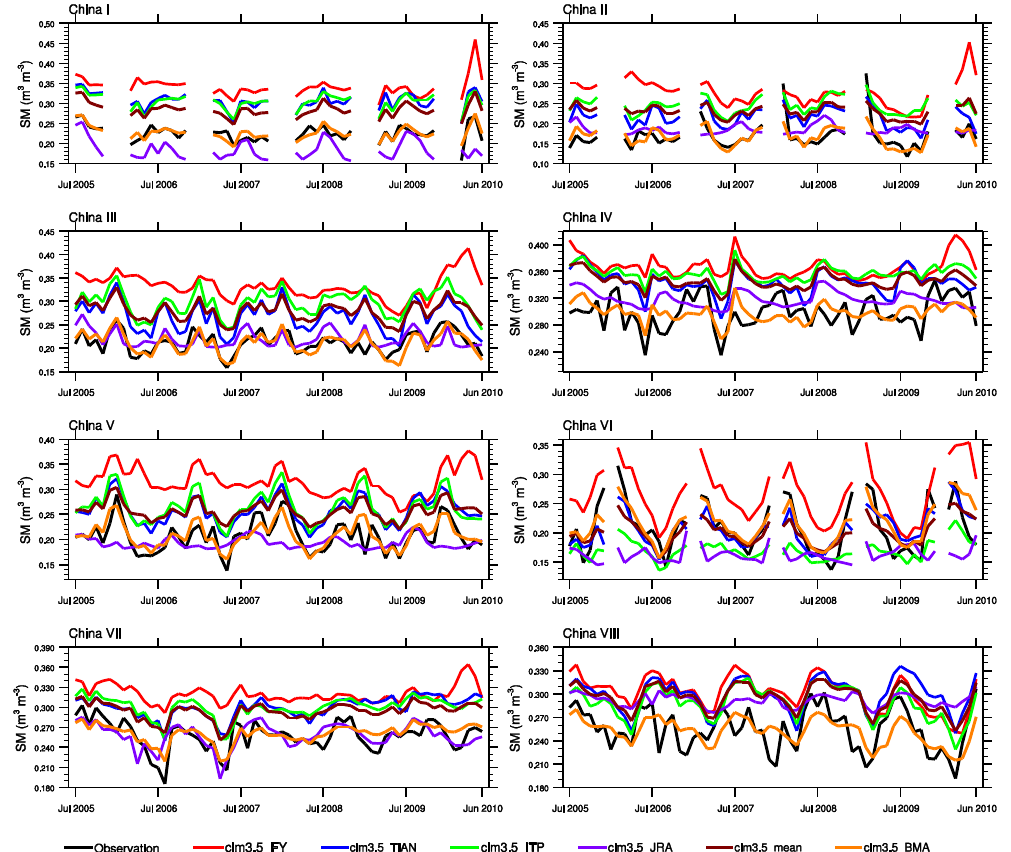
Fig. 6. Time series of monthly volumetric soil moisture (SM, m 3 m − 3 ) for the 0–10cm soil layer from observations, CLM3.5 FY, Fig.6. Time series of monthly volumetric soil moisture (SM, m 3 .m –3 ) for the 0–10 cm 707 CLM3.5 TIAN, LM3.5 ITP, CLM3.5 JRA, CLM3.5 mean and CLM3.5 BMA in the eight subregions of China defined in Table soil layer from observations, CLM3.5_FY, CLM3.5_TIAN, LM3.5_ITP, CLM3.5_ 708 JRA, CLM3.5_mean and CLM3.5_BMA in the eight subregions of China defined in 709